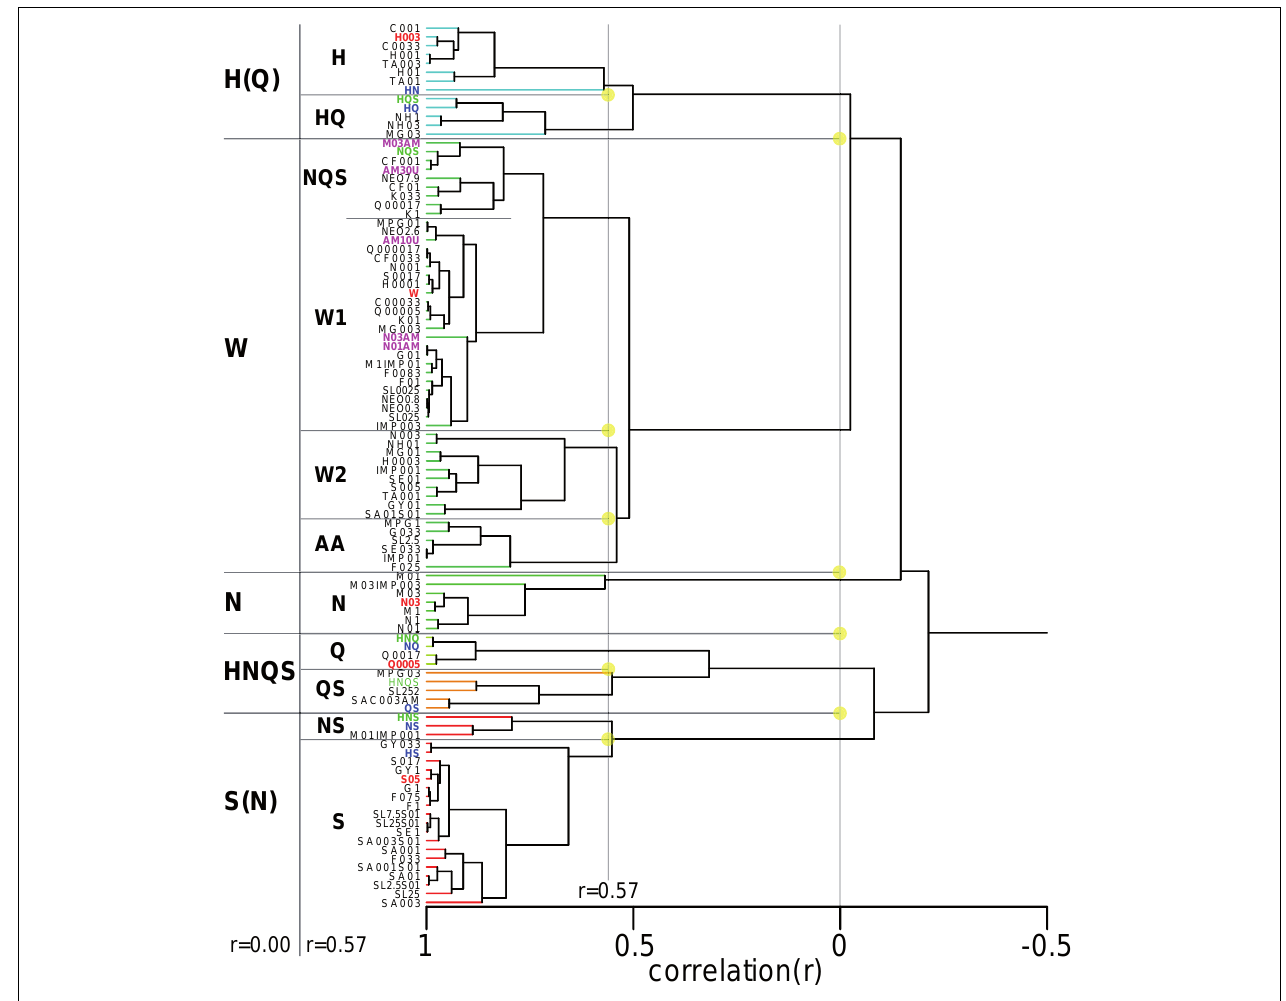
FIGURE 8 | Cluster analysis across all 100 stimuli. Prototypical trained stimuli are indicated in red font. Binary mixtures in dark blue, tertiary, and quaternary in green. Amiloride in cyan. Five clusters are derived at an inter cluster correlation between ∼ r = 0.0 and ∼ r = 0.3.The largest cluster contains the weakest stimuli and